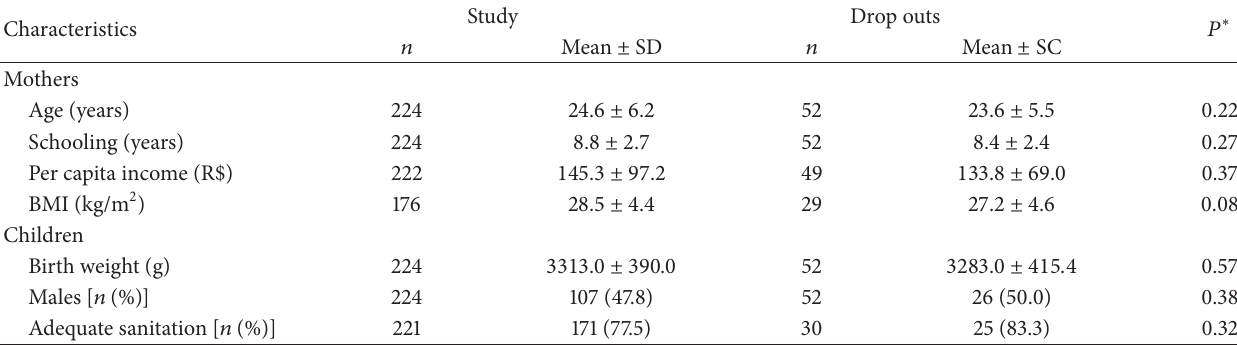
Table 3: Comparison of characteristics of mothers and children followed up by the study with those who dropped out, Recife, PE, 2007/09.